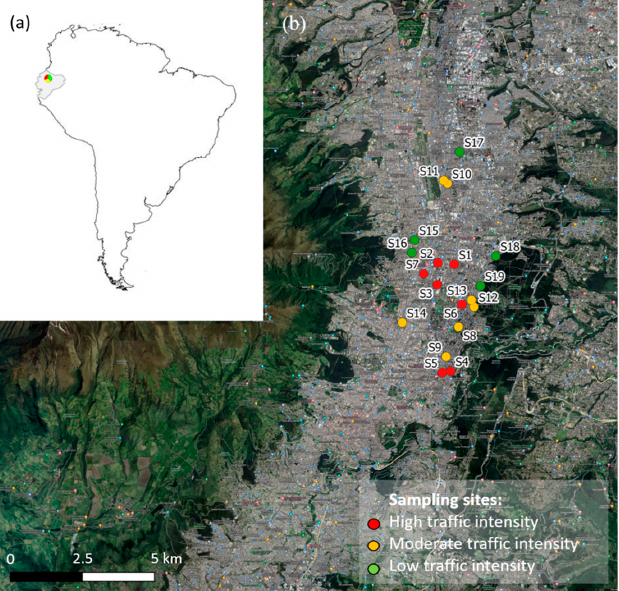
Figure 1. Study area: ( a ) Location of Quito (colored point), Ecuador (gray fill), on the map of South America; ( b ) study sites in Quito.